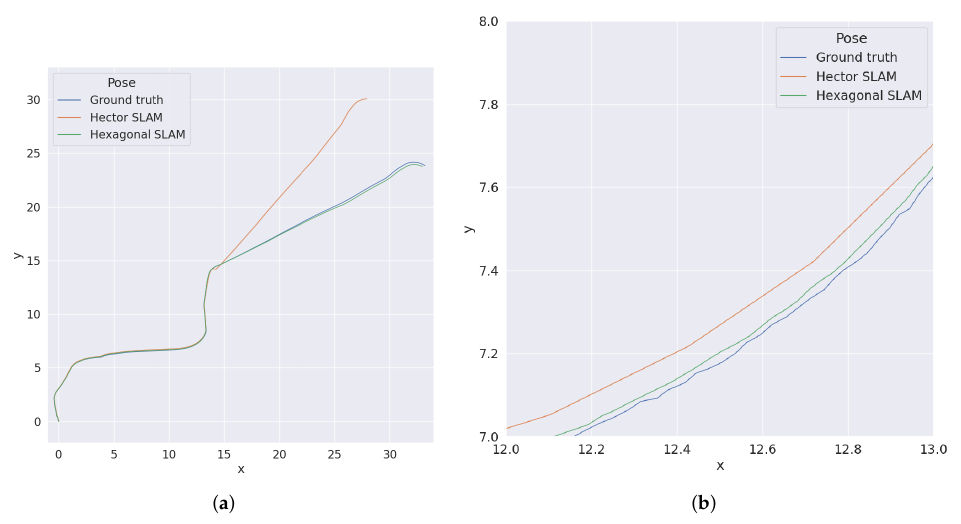
Figure 11. Ground truth position and position estimations for MIT Data Set—recording from 3 April 2012. ( a ) The whole test run. ( b ) Close